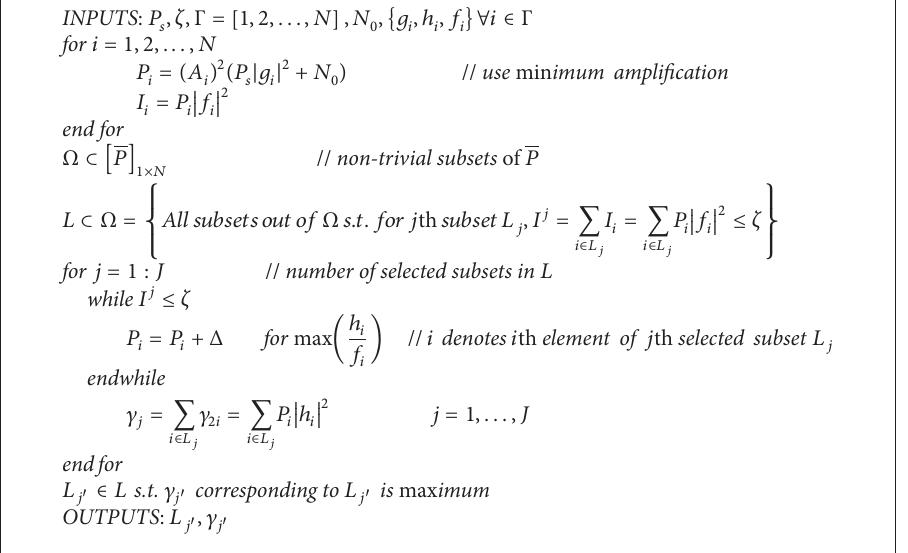
Algorithm 1: The pseudocode of the proposed